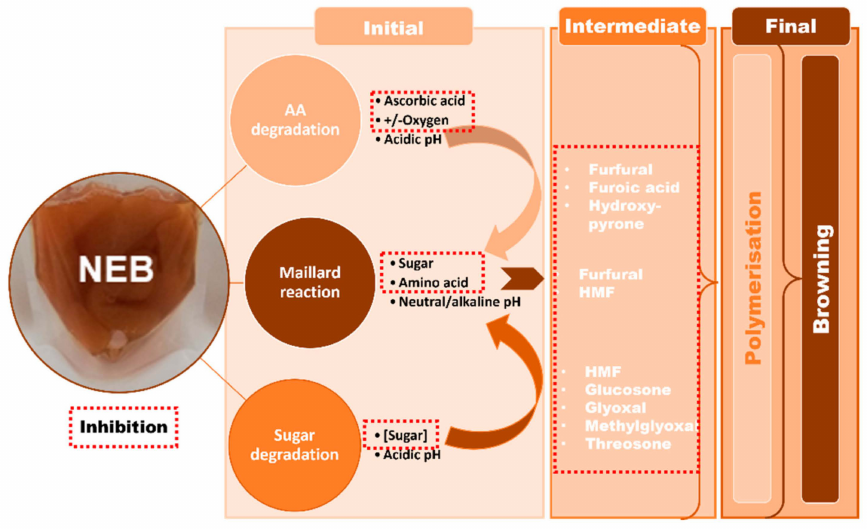
Figure 1. Non-enzymatic browning mechanisms and inhibition in fruit and fruit-based